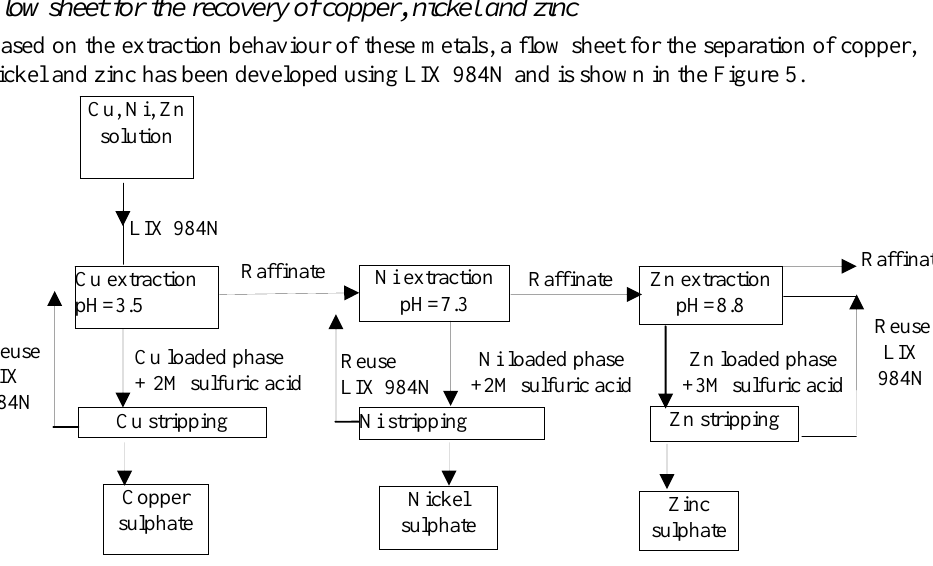
Figure 3. Extraction isotherm of nickel. Aqueous phase: Copper raffinate. Organic phase: 0.05 M LIX 984N. Equilibrium pH: 7.3. Contact time: 20 min. at ambient temperature